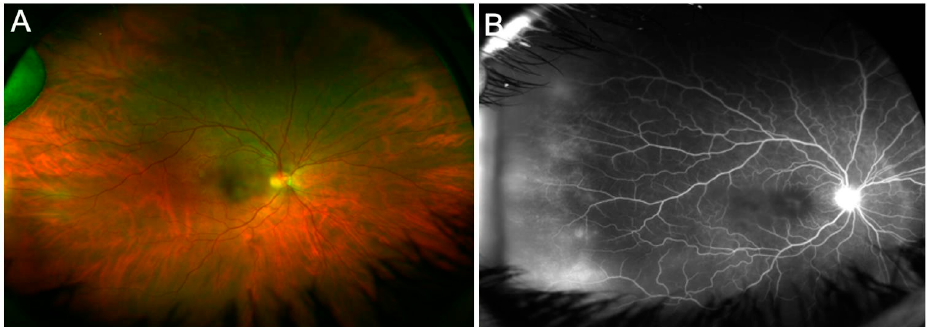
Figure 2. The figure shows a patient (20-year-old Asian Indian male) with tubercular retinal vascu- litis. Fundus examination ( A ) reveals optic nerve hyperemia with retinal vascular sheathing and few hemorrhages. Fluorescein angiography ( B ) reveals active optic nerve head inflammation and peripheral retinal vasculitis.